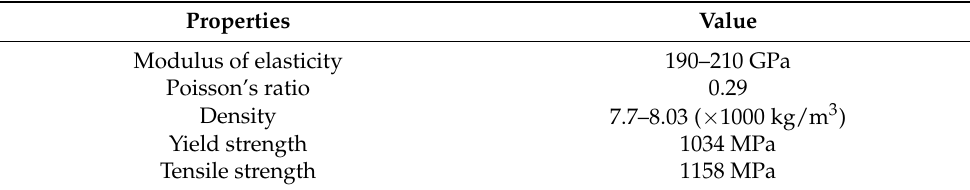
Table 4. SCM420H properties.